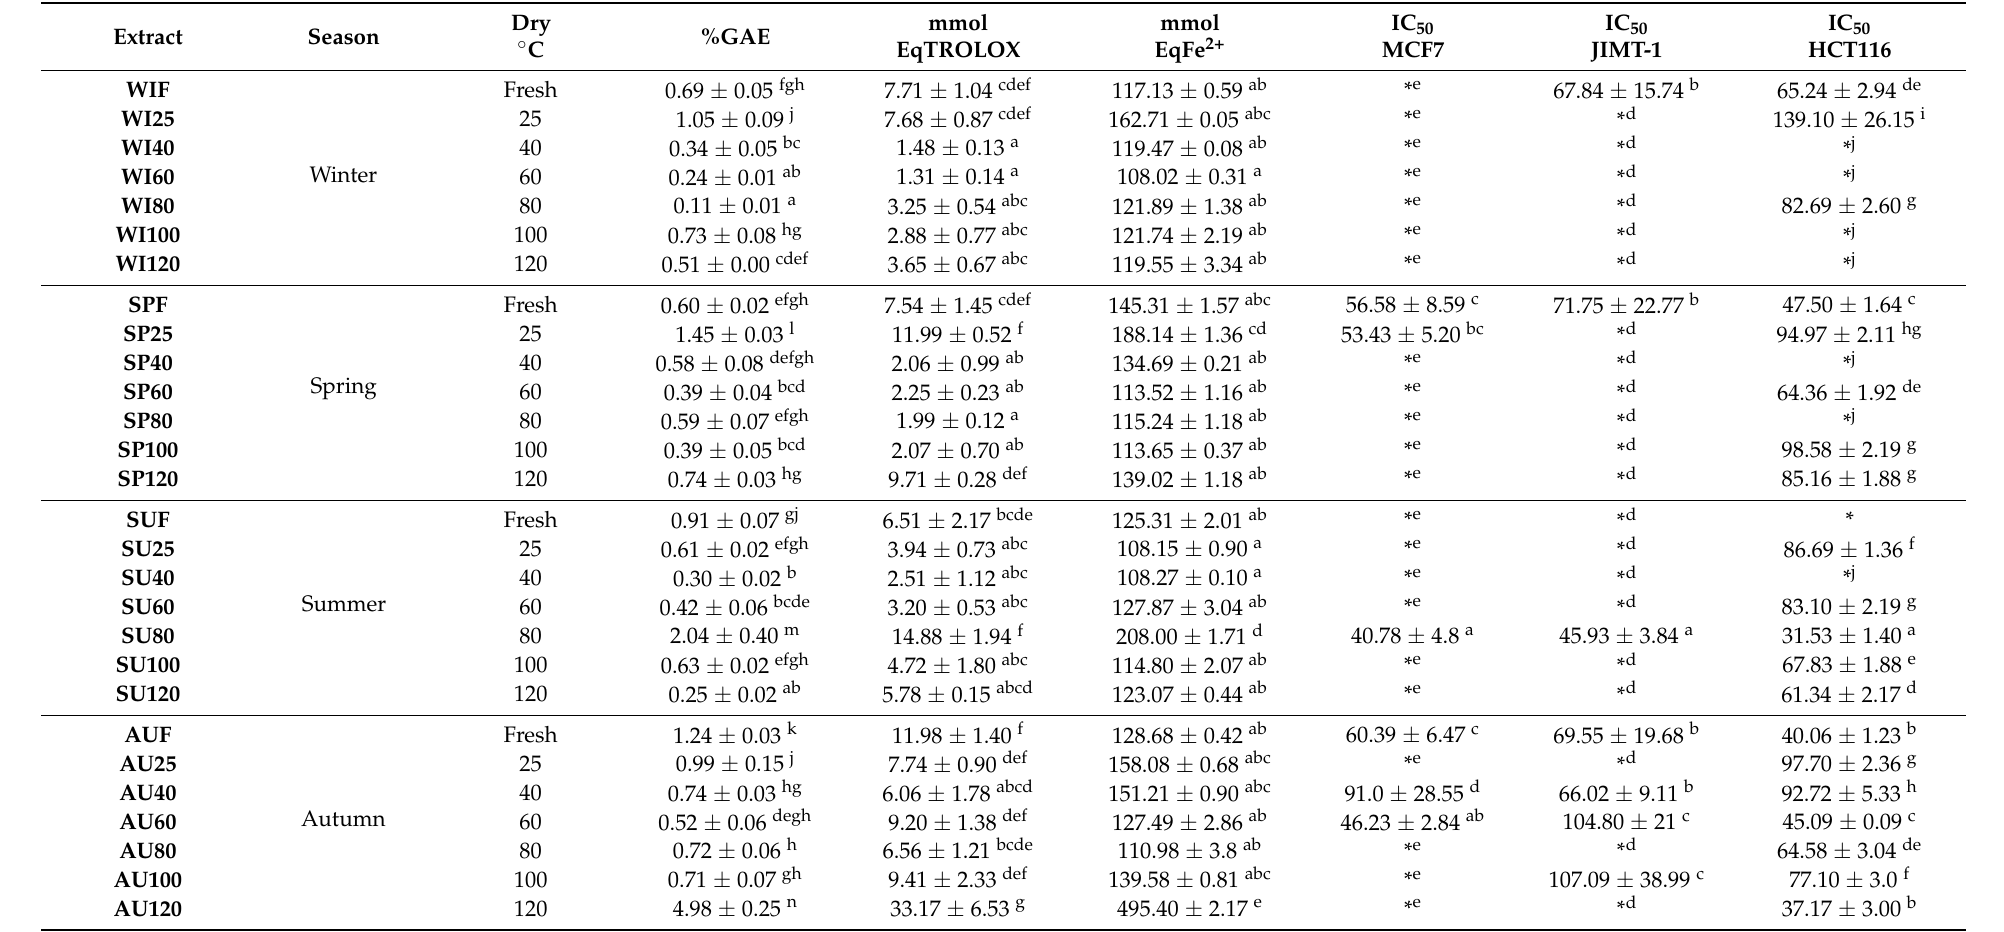
Table 1. Extraction conditions and results of phenolic content, antioxidant and antiproliferative capacity assays for the 28 olive leaf extracts. Statistical significance ( p < 0.05) for each parameter (column) is indicated with letters, and different letters indicate statistically significant